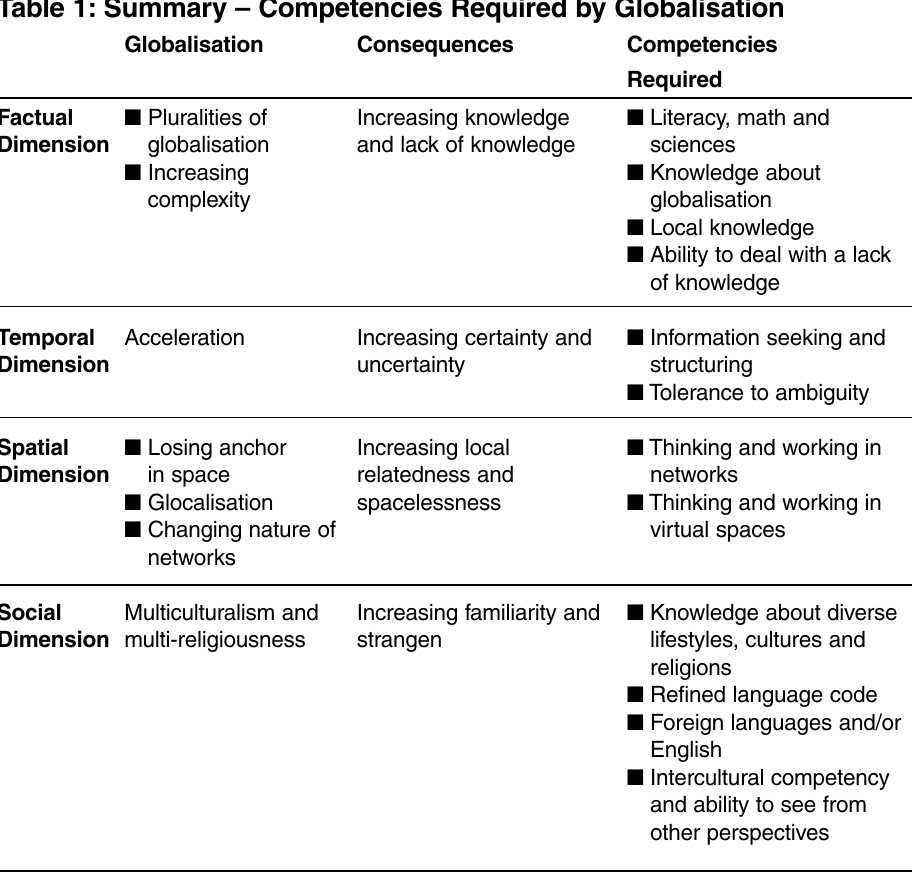
Table 1: Summary – Competencies Required by